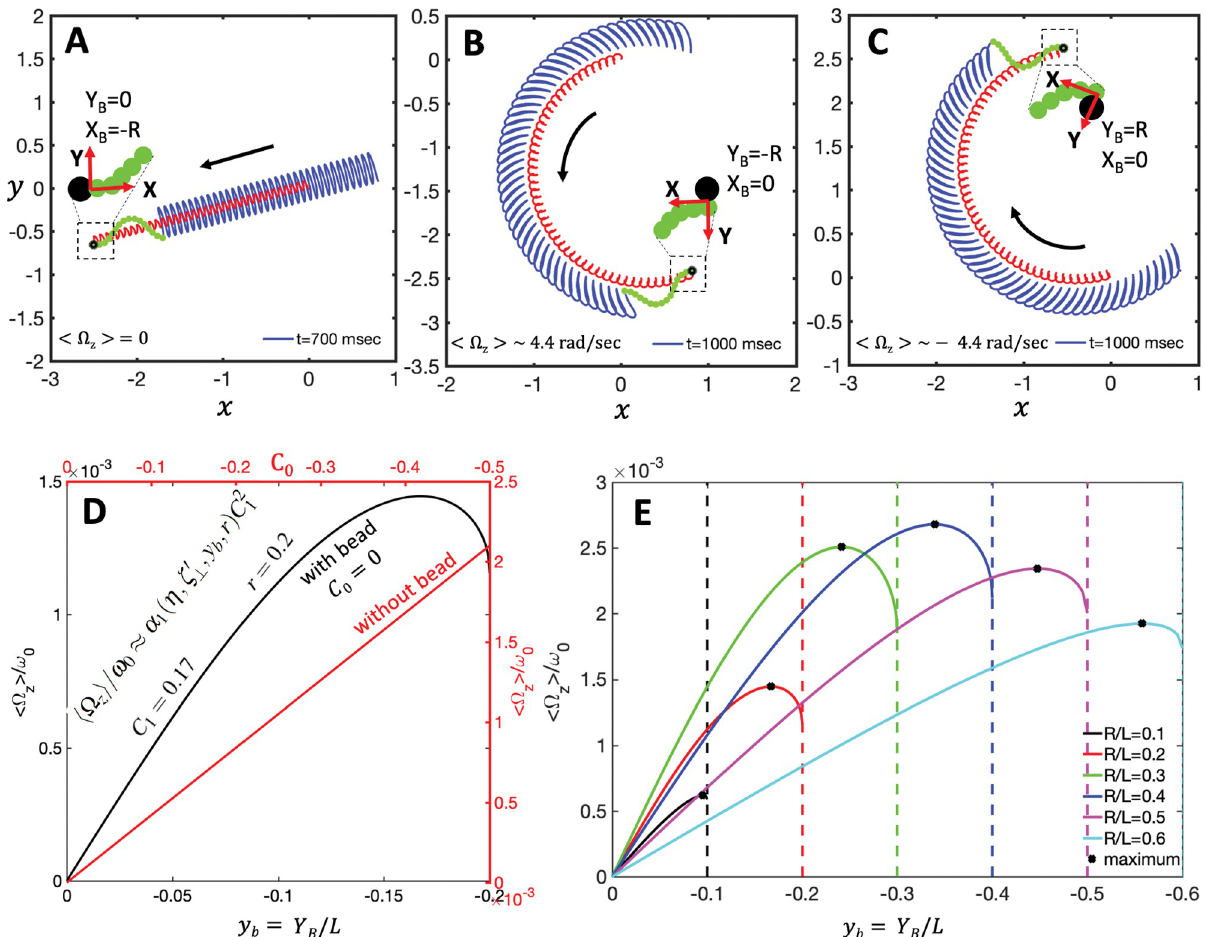
Fig 7. A-C) Asymmetric versus symmetric bead attachment to an axoneme with a beat pattern consisting only of the traveling wave component C 1 ( C 0 = 0 in Eq 19). While the axoneme in panel A, to which the bead is symmetrically attached, swims on a straight path (S3 Video), the axonemes in panel B (S4 Video) and C (S5 Video), with an asymmetric bead attachment, swim on curved paths. D) Comparison of the effect of the asymmetric bead attachment (in black) as a function of y = Y / L versus the effect of the intrinsic curvature C 0 (in red) on h O b B changes non-monotonically with y b for different bead radii. X B and Y B are the coordinates of the bead center in the swimmer-fixed reference frame. Parameters are η = 0.5, z 0 ¼ 4 : 33 and C 1 = ?